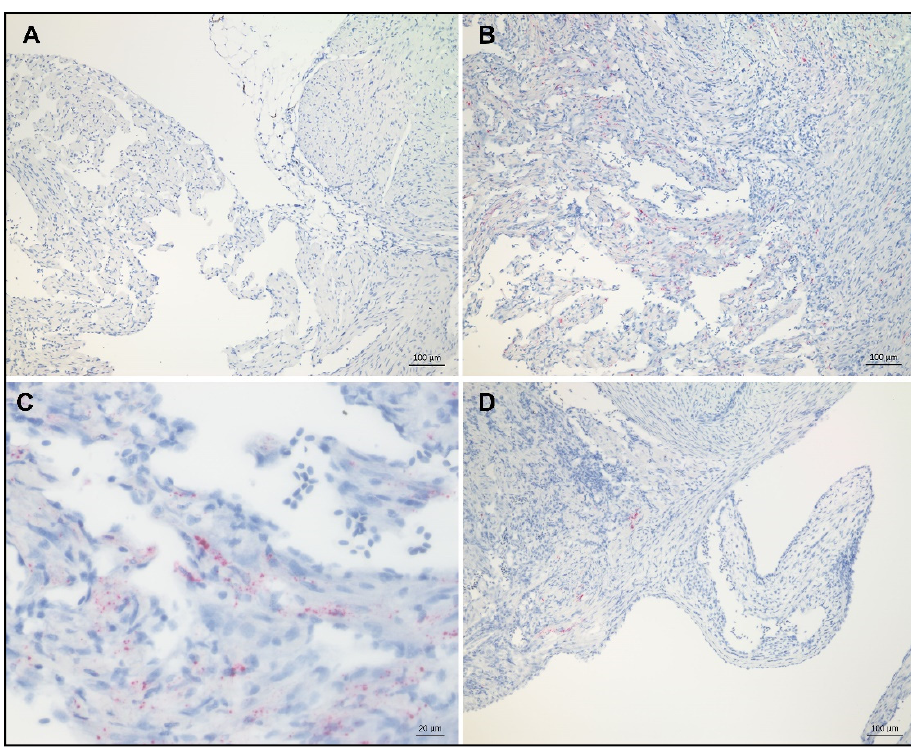
Figure 3. In situ hybridization of nonstructural protein (nsP)1 transcripts in the hearts of SAV-naïve Atlantic salmon at 0, 35, and 42 days post-SAV challenge (dpc). Images taken from representative individuals within each group. Localization of SAV transcripts shown by in situ hybridization of nsP1 in the hearts of unvaccinated fish. ( A ) No positive signal at 0 dpc; ( B , C ) virus was mainly detected in the stratum spongiosum of the ventricle at 35 dpc; ( D ) virus detected sparingly, mainly in the stratum spongiosum of the ventricle, at 42 dpc.